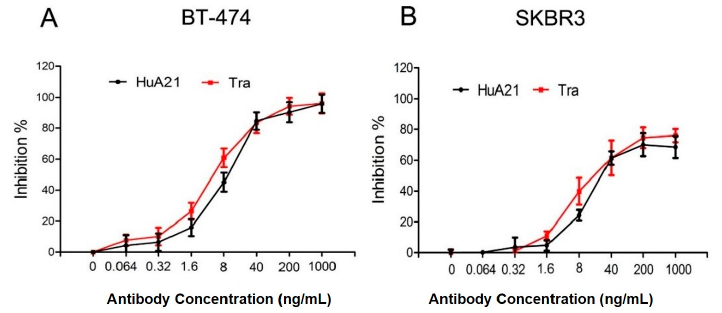
Figure 2. HuA21-mediated ADCC against HER2-positive breast cancer cells SKBR3 ( A ) and BT-474 ( B ) cells were pre-incubated with the indicated concentrations of HuA21 or trastuzumab (Tra). The ADCC experiments were performed in triplicate, and the data are representative of three separate experiments.